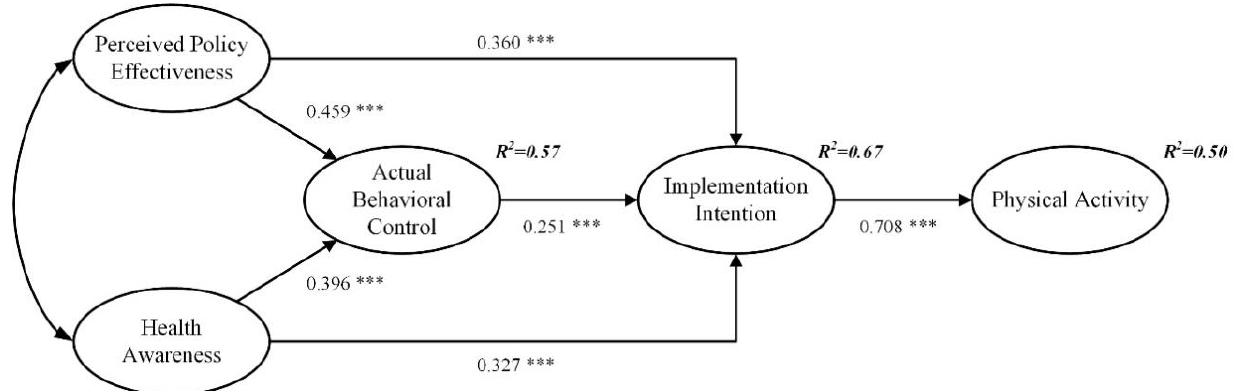
Figure 2. Structural path model. *** p < 0.001; standardized coefficients are reported.